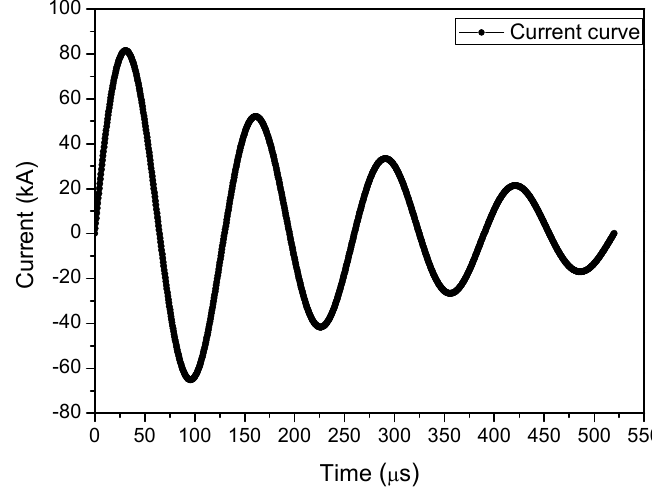
Figure 6. A current waveform for a multi-spot weld of an 8 kJ discharge energy.